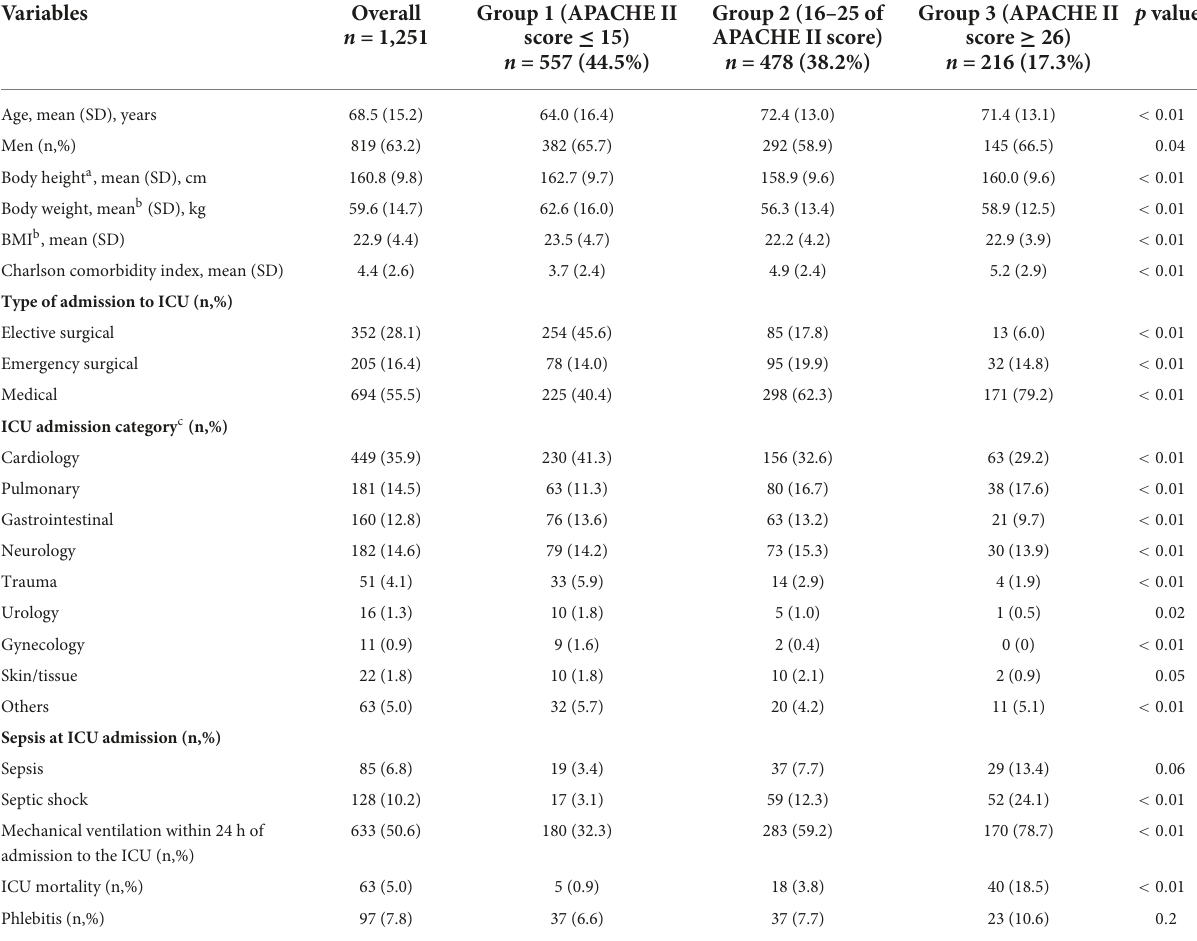
TABLE 1 Patient characteristics at ICU admission stratified using the APACHE II